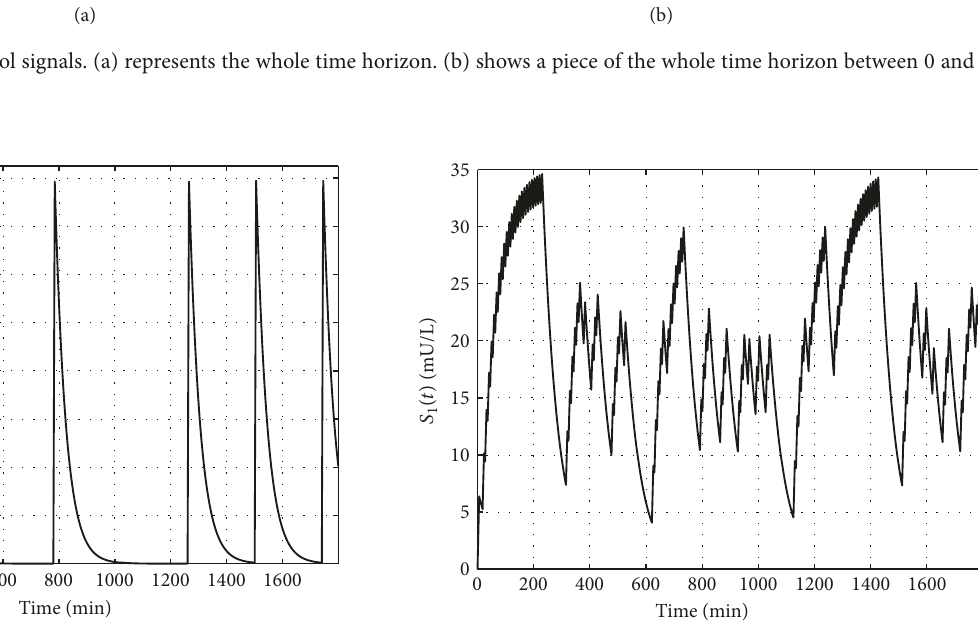
Figure 3: Variation of the first state of the glucose absorption subsystem.